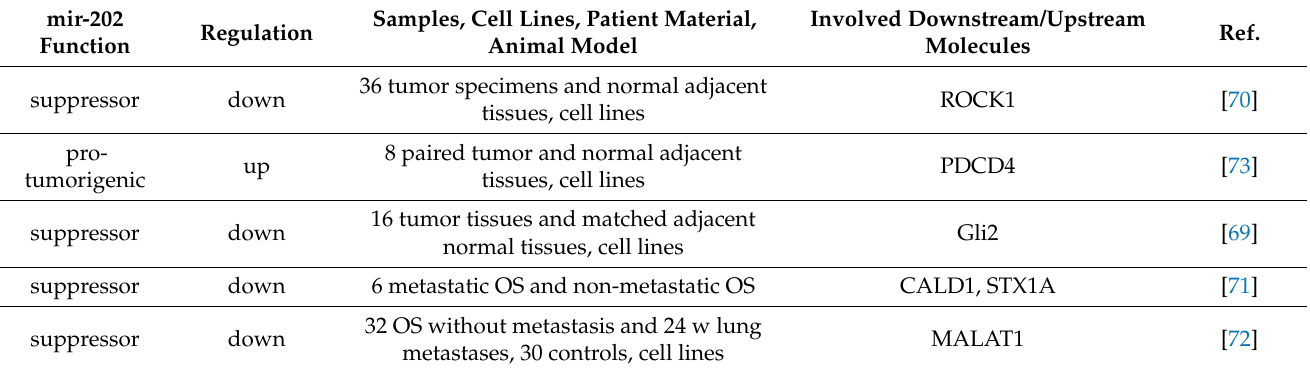
Table 5. Role of miR-202 in Osteosarcoma.